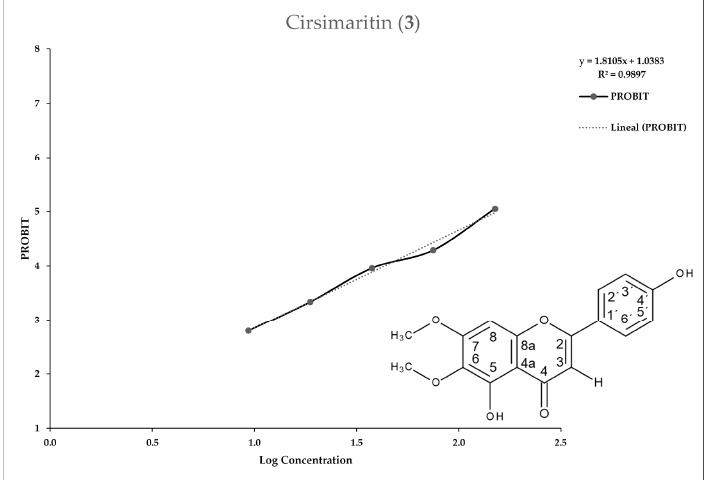
Figure 4. Antiprotozoal activity of Cirsimaritin 3 against Entamoeba histolytica . Growth inhibition of 52.45% at 150 µ g / mL, IC 50 = 154.26 µ g / mL.